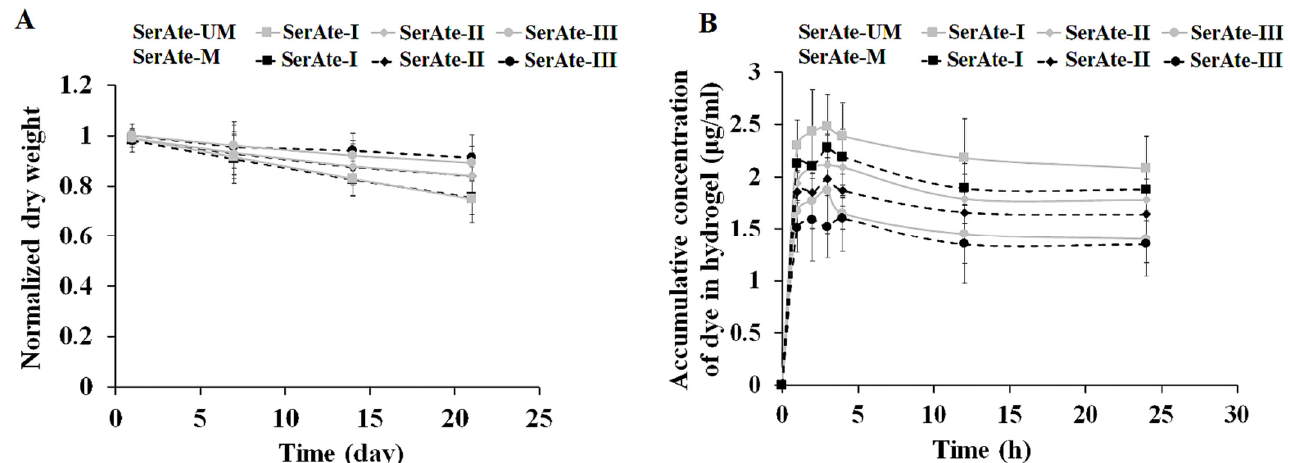
Figure 6. Effect of degree of modification on mass loss ( A ) and dye uptake ( B ) of SerAte-UM and SerAte-M hydrogels (15 wt% SerAte) in PBS at ambient conditions. The values are expressed as means ± SD for n = 3.